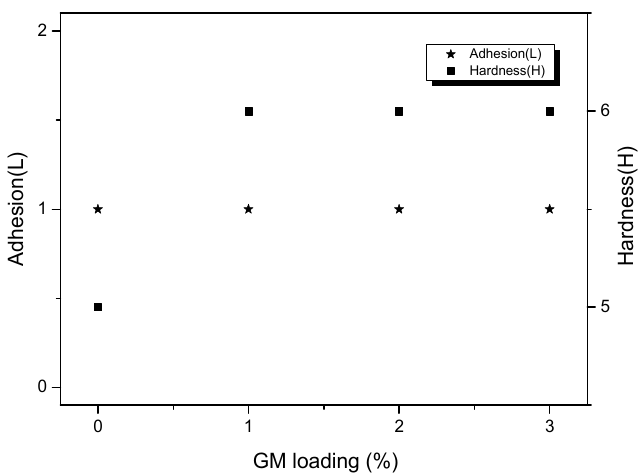
Figure 6. Adhesion and hardness values of CNC/GM/ two-component waterborne polyurethane coatings (2K-WPU).